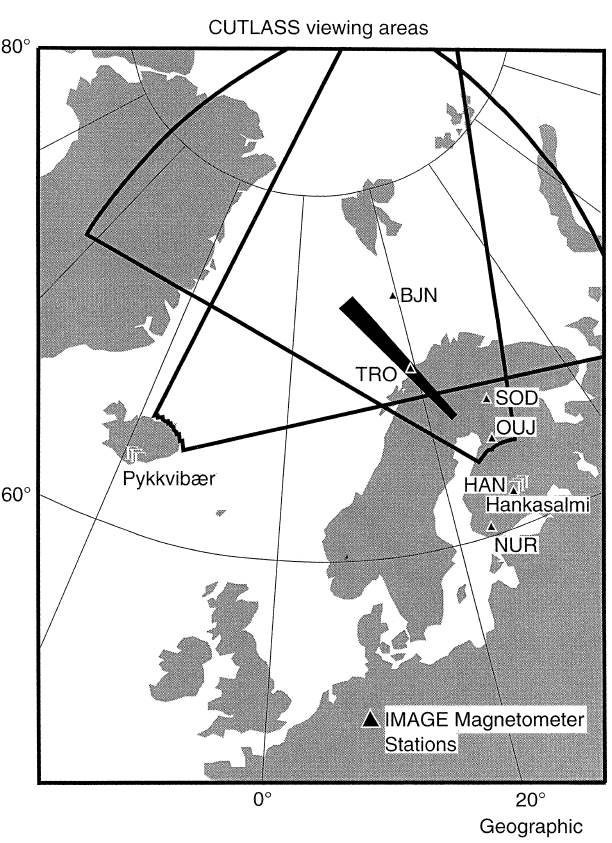
Fig. 1. Locations of the IMAGE magnetometer stations used in this study and the fields-of-view of the CUTLASS radars. The location of the CUTLASS Finland 15 km resolution single beam experiment is marked as a solid black